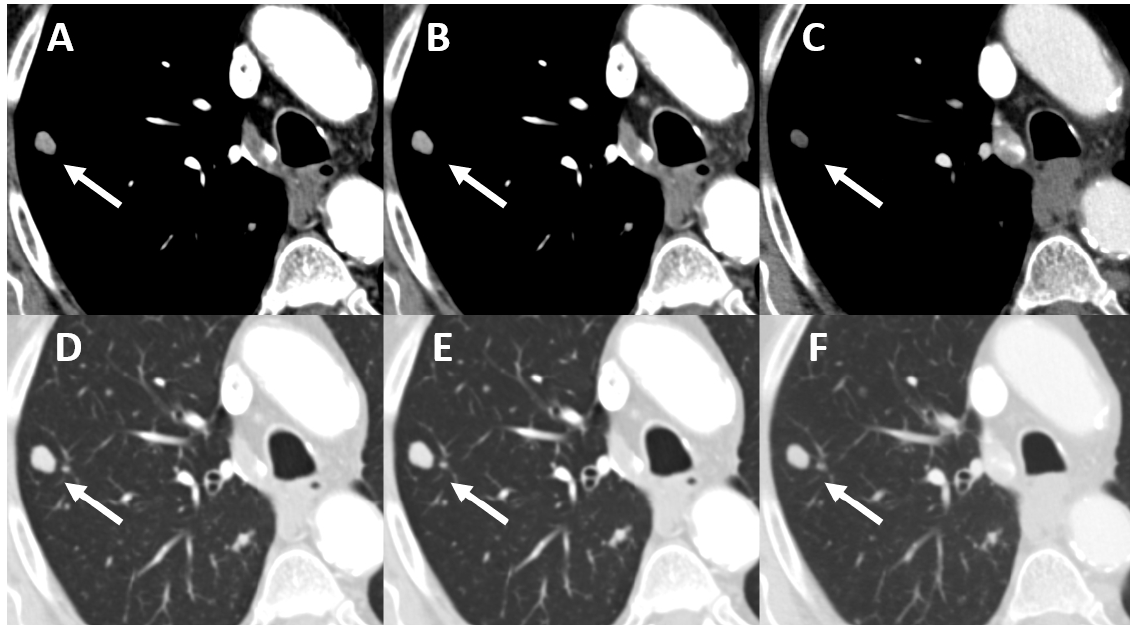
Figure 1. Pulmonary metastasis (arrows) of a colorectal carcinoma in a 75-year-old man. Tumor size: ( C , F ) 9 mm, ( A , B , D , E ) 10.5 mm, timespan between the examinations: 3 months.